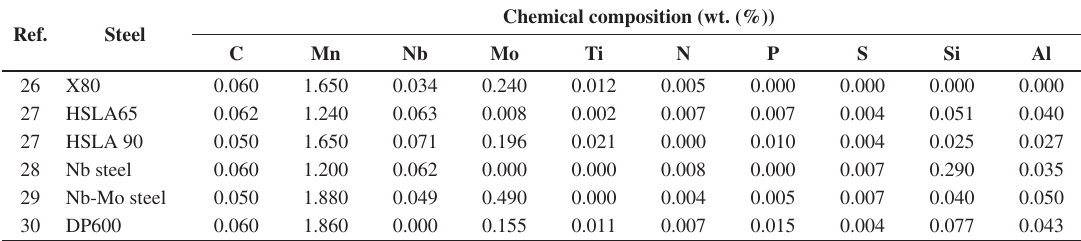
Chemical composition (wt. (%))